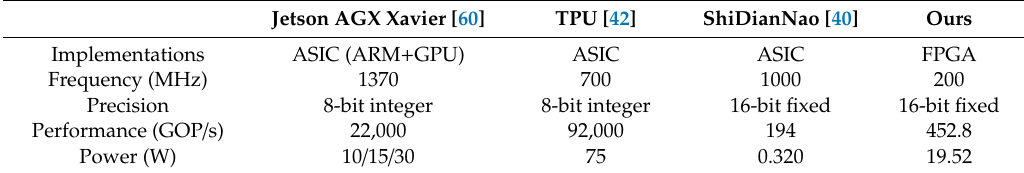
Table 6. Comparison of deep learning processors with di ff erent